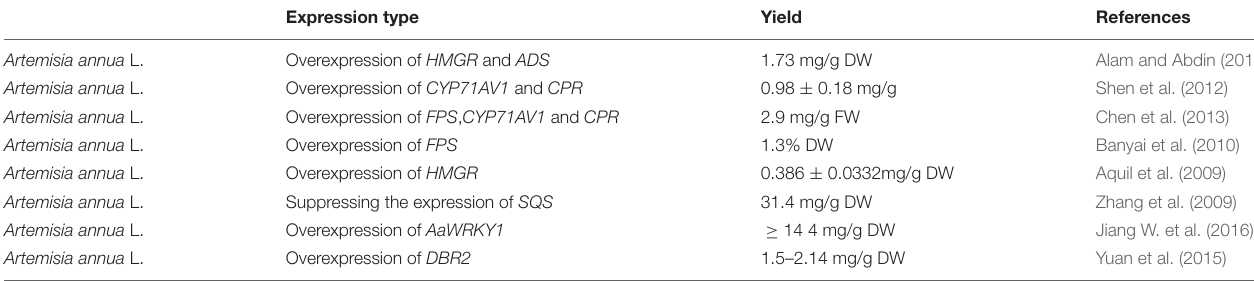
TABLE 2 | Introducing artemisinin (ART) pathway genes in Artemisia annua L. to improve the ART production using different strategies. Expression type